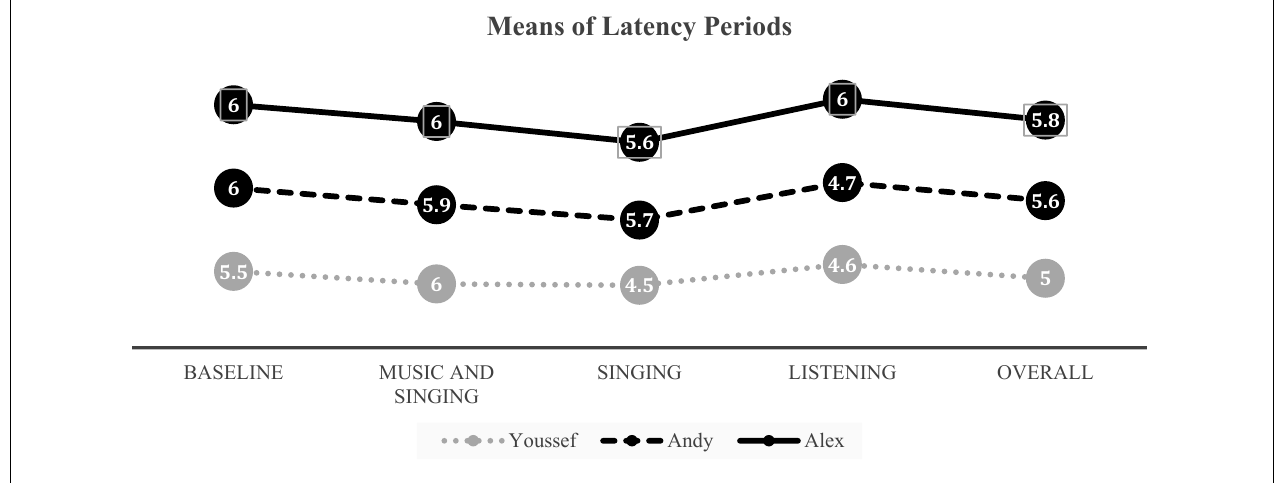
FIGURE 3 | Means of latency for the three participants during each of the musical interventions.